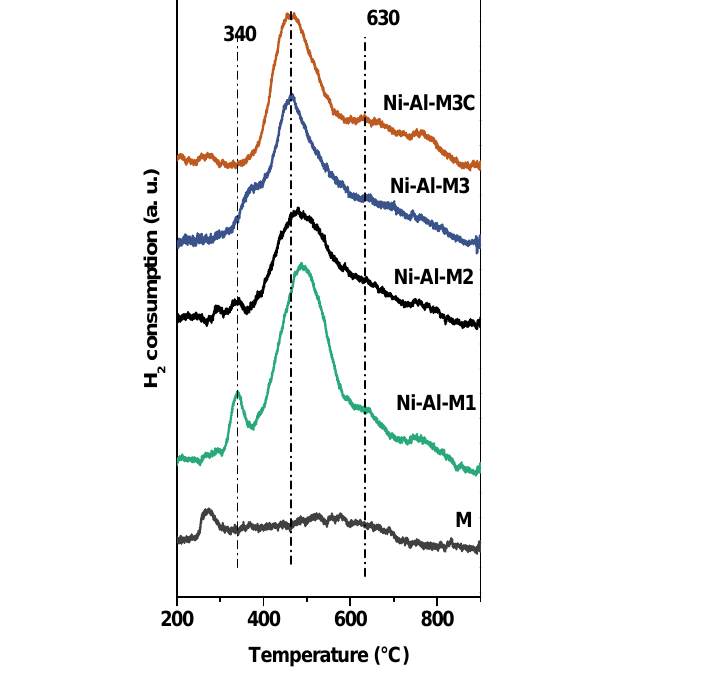
Figure 7. TPR profiles of the structured catalysts and a FeCrAlloy ® sheet calcined at 900 °C for 22 h (M).